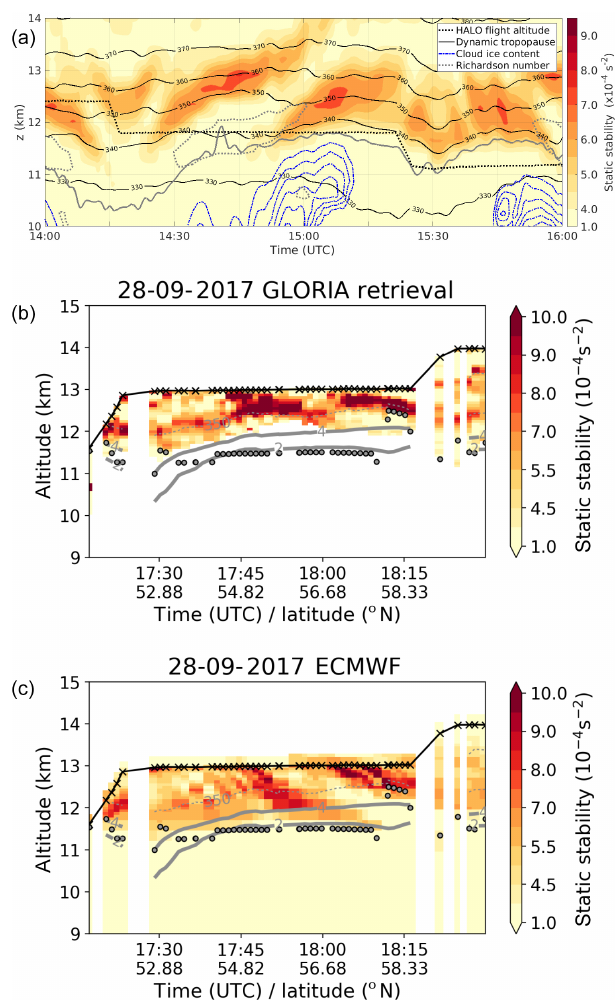
Figure 3. (a) Static stability along the flight path between 14:00 and 16:00UTC (color-shaded) along with potential temperature (black solid), cloud ice water content (blue dashed), the altitude of the dy- namic tropopause (gray solid), and the Richardson number smaller than 1 (gray dotted) based on ECMWF forecast data. Black dotted line shows the altitude of HALO. (b) Static stability at GLORIA tangent points between 17:20 and 18:20UTC. Black line shows the flight altitude with black crosses marking points of measurement. Thick gray lines show 2 and 4pvu, thin gray line the 350K isen- trope based on ECMWF forecast data. Gray dotted points mark the location of the first lapse rate tropopause. (c) ECMWF forecast data sampled at GLORIA tangent